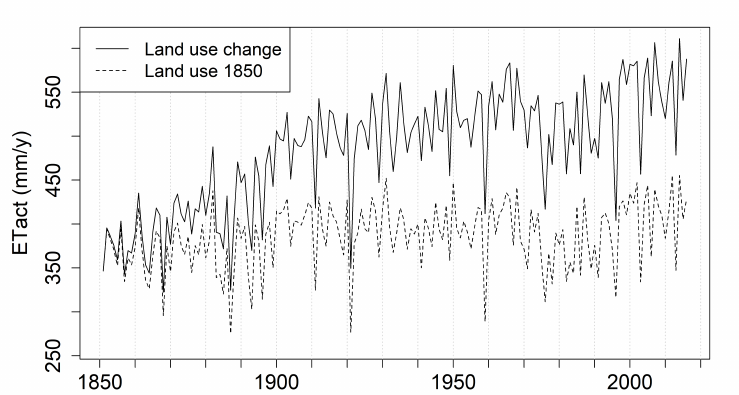
Figure 6. Mean yearly ET act simulated with land use change and with a constant land use from